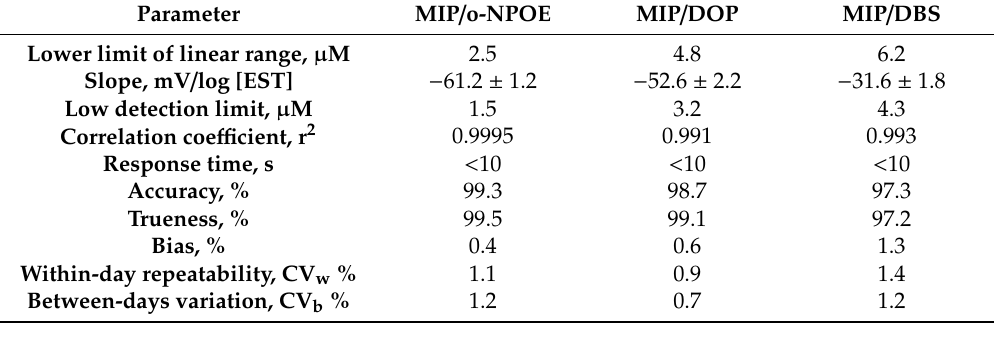
Table 1. Performance characteristics of 17 β -estradiol PVC membrane sensor in 50 mM HCO 3 − / CO 32 −